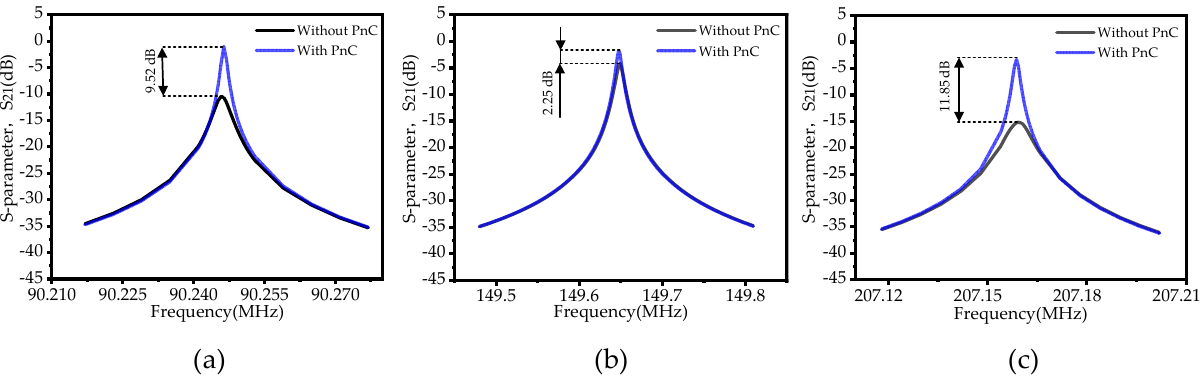
Figure 12. Comparison of insertion loss ( S 21 ) curves of three consecutive overtones (( a ) third − order overtone, ( b ) fifth − order overtone, and ( c ) seventh − order overtone). Table 4. Comparison of performance parameters of four MEMS resonators.